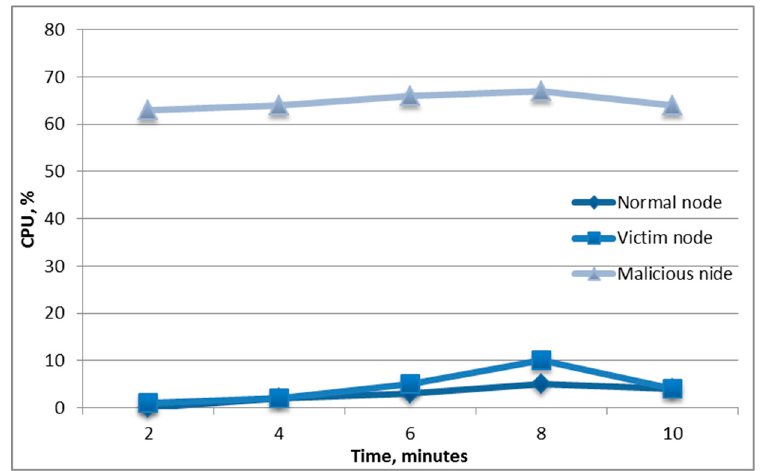
Figure 12. The CPU consumption of the nodes under the deauthentication attack.